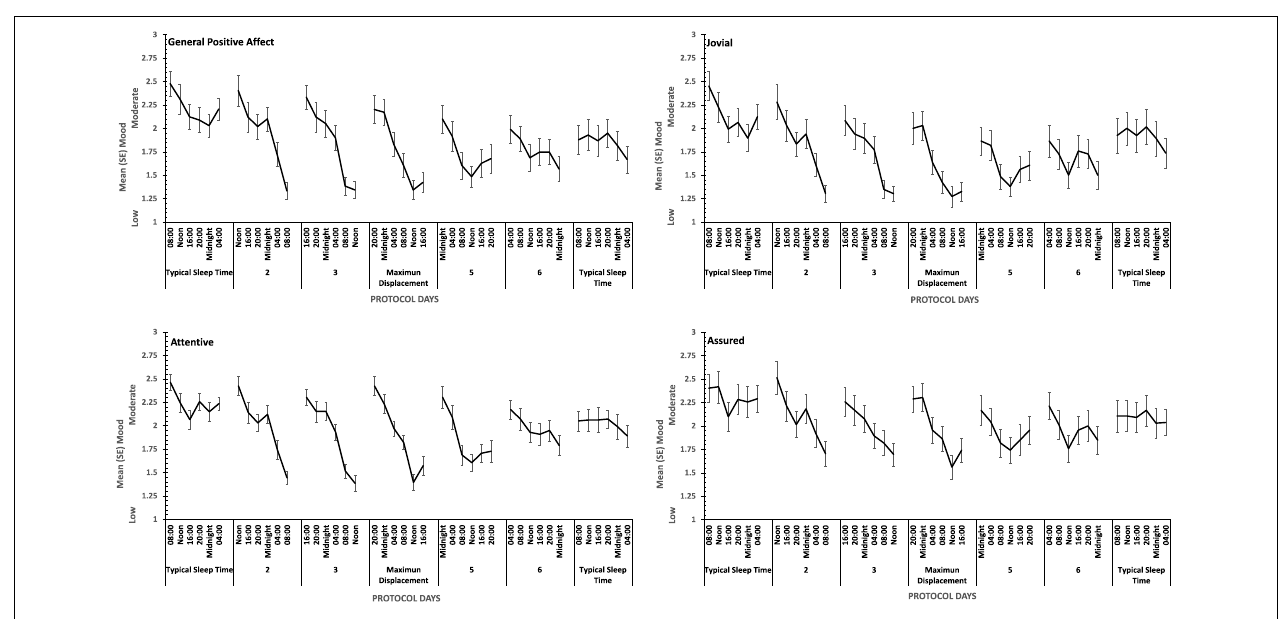
FIGURE 8 | Effects of circadian phase on Positive mood (General Positive Affect, Assuredness, Joviality, Attentiveness) across a week-long 28hr Forced Desynchrony protocol.